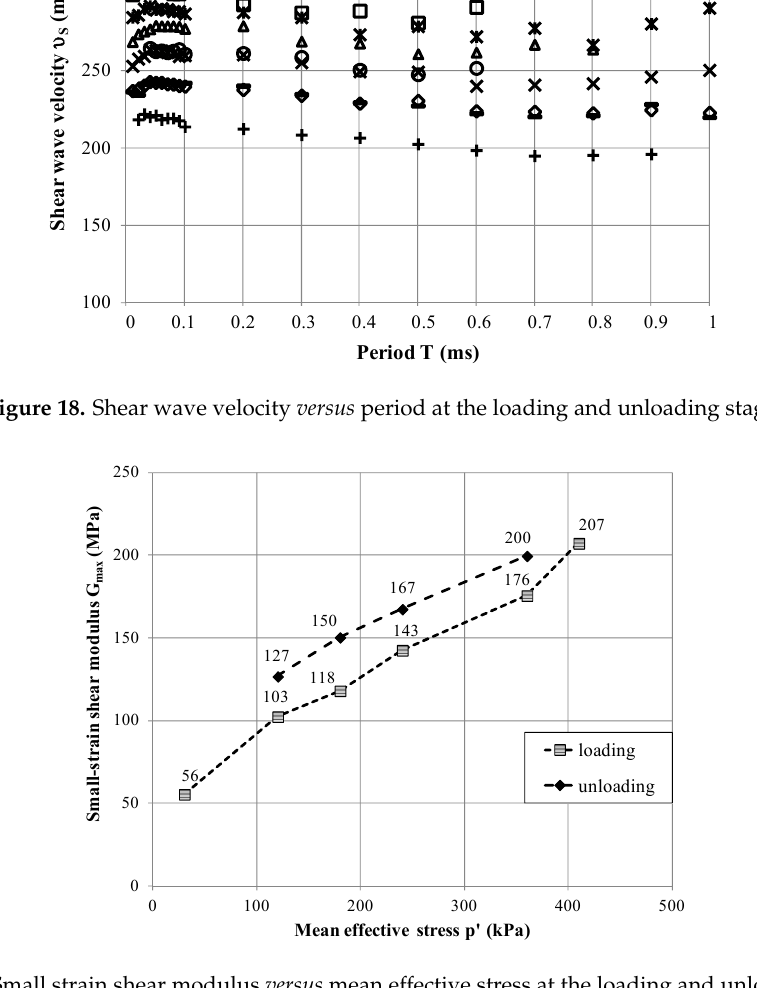
Figure 19. Small strain shear modulus versus mean effective stress at the loading and unloading stage.